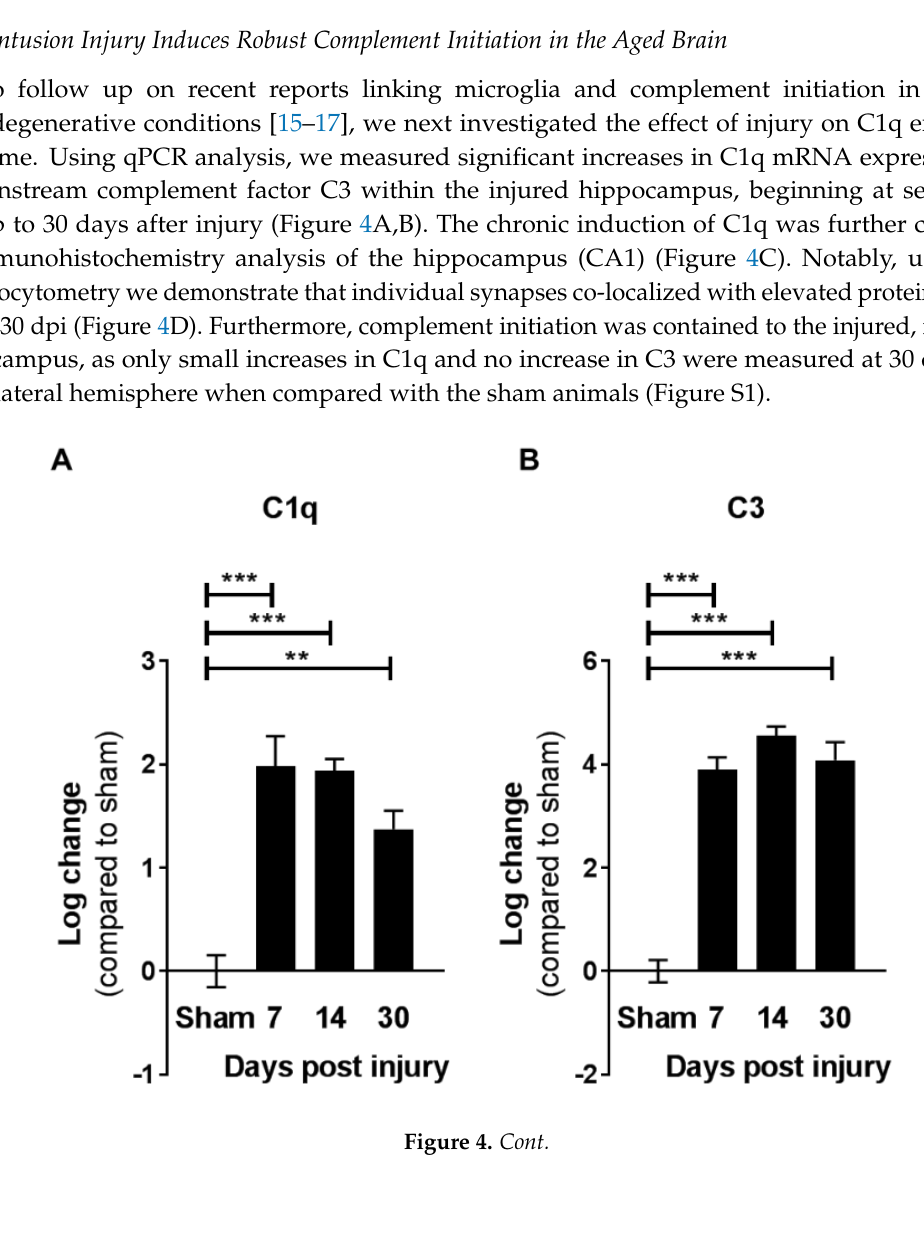
Figure 4. Contusion injury induces robust complement initiation in the aged brain. Complement initiation components ( A ) C1q and ( B ) C3 gene-expression changes in the hippocampus of aged animals were measured by qPCR analysis, comparing expression levels between sham animals, and those 17, 14, and 30 days post injury. Both C1q and C3 expression levels were increased after injury. One-way ANOVA revealed significant differences (C1q-F = 15.89; p < 0.0001; C3-F = 50.58; p < 0.0001). Bonferroni post hoc test revealed differences between groups; n = 4–6/group. ( C ) C1q protein expression was measured by immunohistochemical staining in the dorsal hippocampus. Representative images from sham and TBI (30 dpi) animals (inset, in red C1q staining and in blue cell body counterstaining). C1q protein expression increased chronically after injury. No reactivity was observed in secondary alone. White scale bar = 50 µm; 200× magnification; n = 4–6/group. ( D ) Hippocampi were collected and synaptosomes were isolated by sucrose gradient followed by size calibration beads. C1q co-localization of synapse was measured by antibody staining. TBI (30 dpi) significantly increases C1q accumulation at synapse when compared with sham animals. Student’s t -